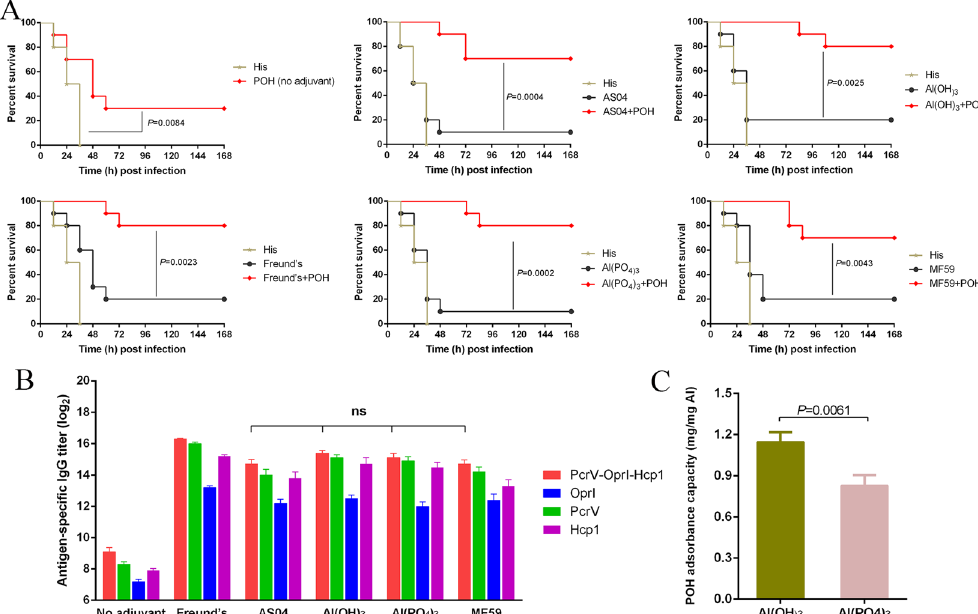
Figure 2. Validation of the optimal adjuvant for the recombinant protein POH in the pneumonia model. ( A ) BALB/c mice (n = 10) were immunized with the same doses of POH or POH plus different adjuvants (Freund’s, AS04, Al(OH) 3 , AlPO 4 and MF59). The control groups included the adjuvant groups and the His buffer group. All of the mice were challenged with P . aeruginosa strain PAO1 at 1.0 × 10 7 CFUs/mouse by intratracheal injection, and mouse survival was monitored for 1 week. The P -value was compared with the adjuvant control group using the Mantel-Cox log-rank test. ( B ) Plates were coated with POH, OprI, PcrV, and Hcp1, respectively. And serum was collected from mice (n = 10) in ( A ) immunized with POH or POH plus different adjuvants (Freund’s, AS04, Al(OH) 3 , AlPO 4 and MF59) on day 28 before challenge. Antibody responses were expressed as the mean of log 2 titers. Multiple comparisons among different groups were analyzed using one-way ANOVA (ns = no significance). Data were shown as the mean ± SEM. ( C ) Adsorption capacity of aluminum adjuvant. Student’s t-test was used to compare values. Data were shown as the mean ±